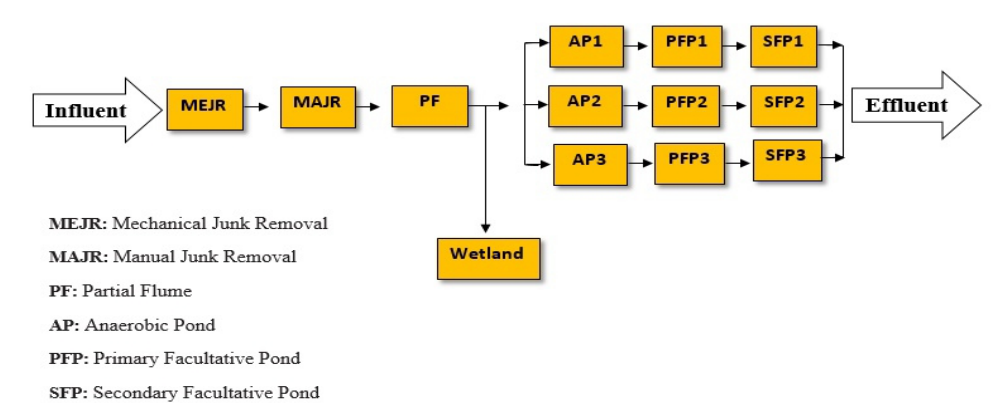
Fig. 1. Schematic flow diagram of WSPs in Yazd, Iran